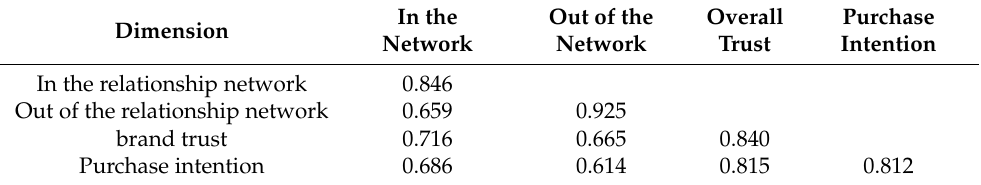
Table 4. Discriminant validity test.